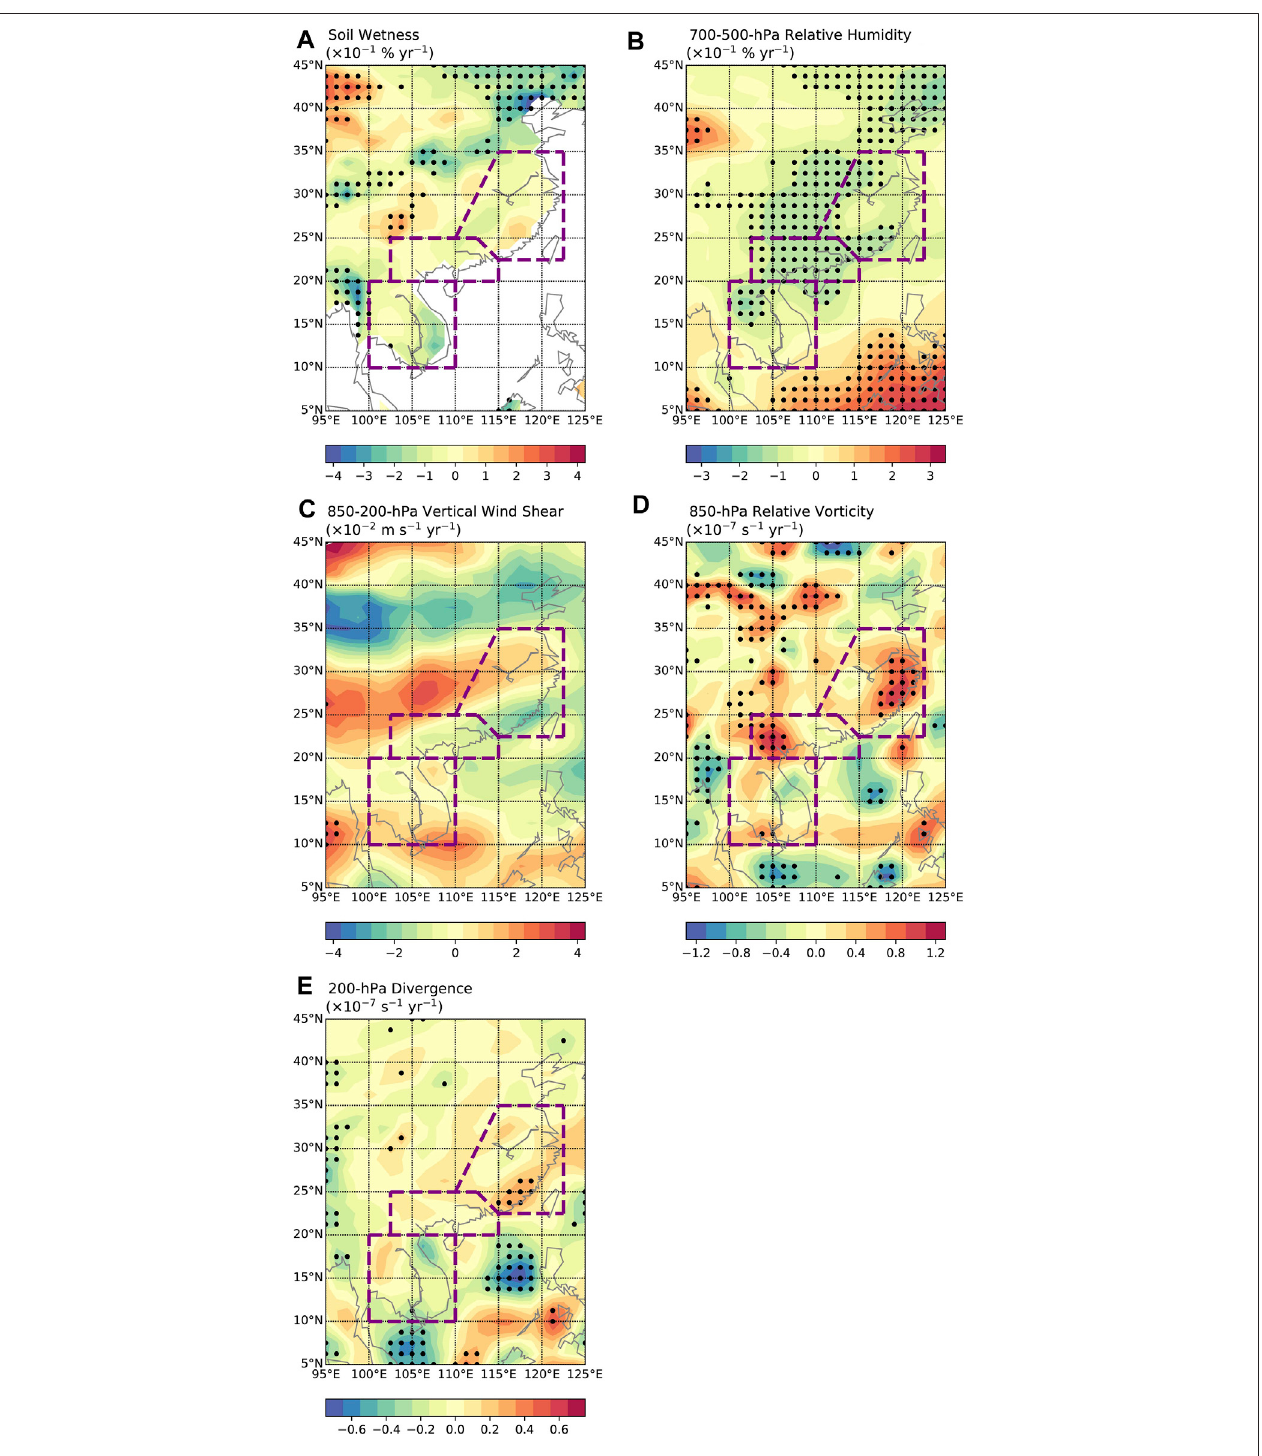
FIGURE 6 | Long-terms trends (1966 – 2018) in June-November averages of environmental variables: (A) soil wetness, (B) 700 – 500-hPa RH, (C) 850 – 200-hPa VWS, (D) 850-hPa VOR and (E) 200-hPa DIV. Circles denote values signi fi cant at the 0.05 level based on an F -test. Areas bounded by purple dashed lines refer to the main occurrence region of landfalls for the three clusters, as was demarcated in Figure 1A .